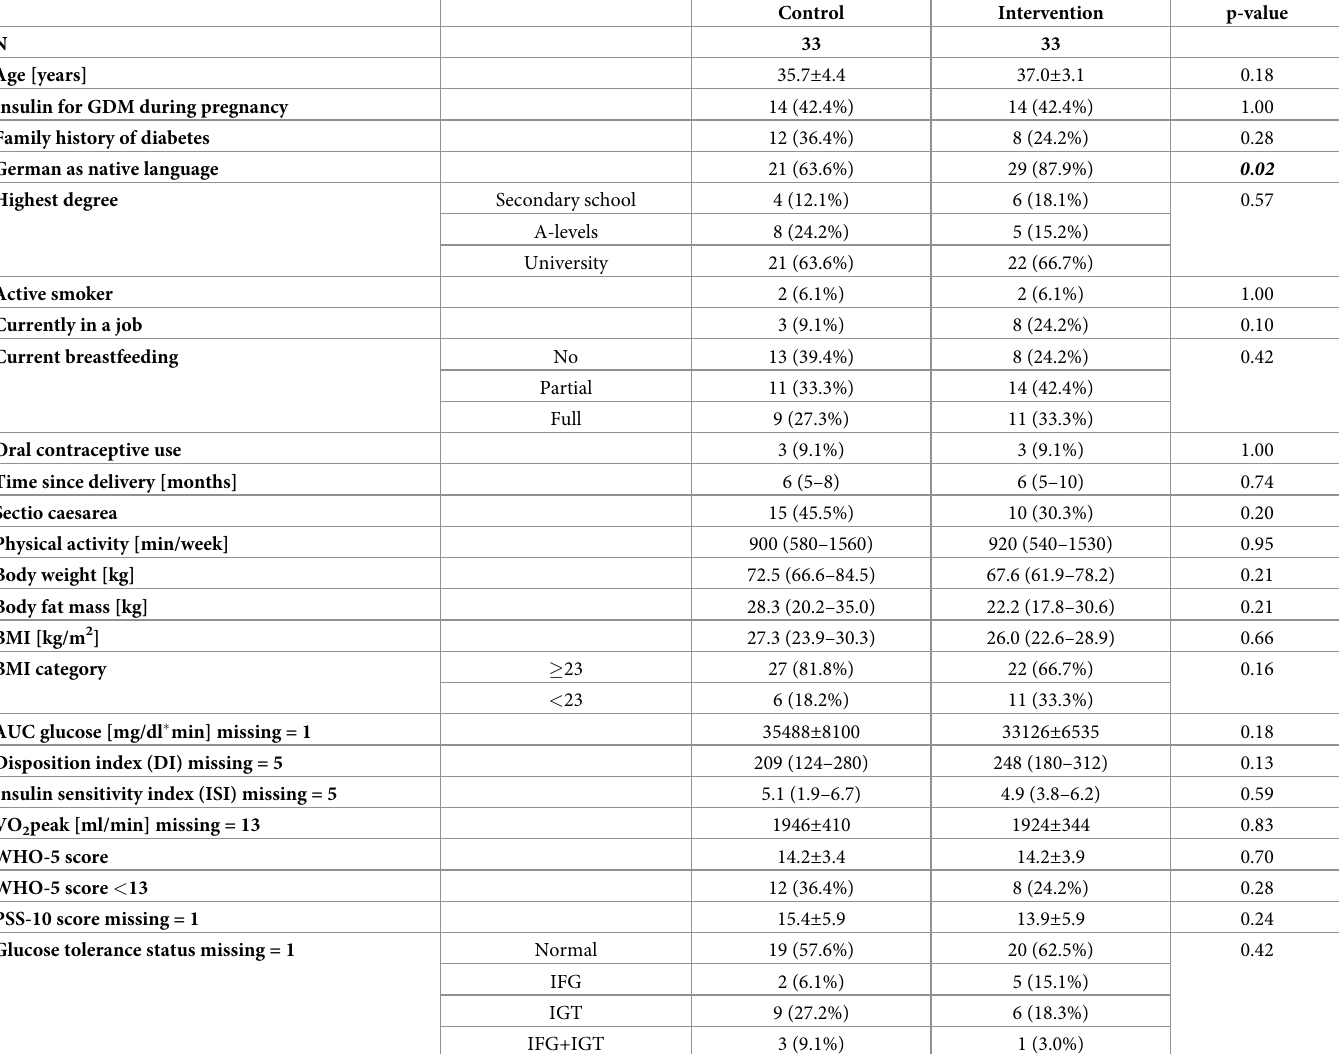
Table 1. Baseline characteristics of the control and intervention group Test TRIANGLE